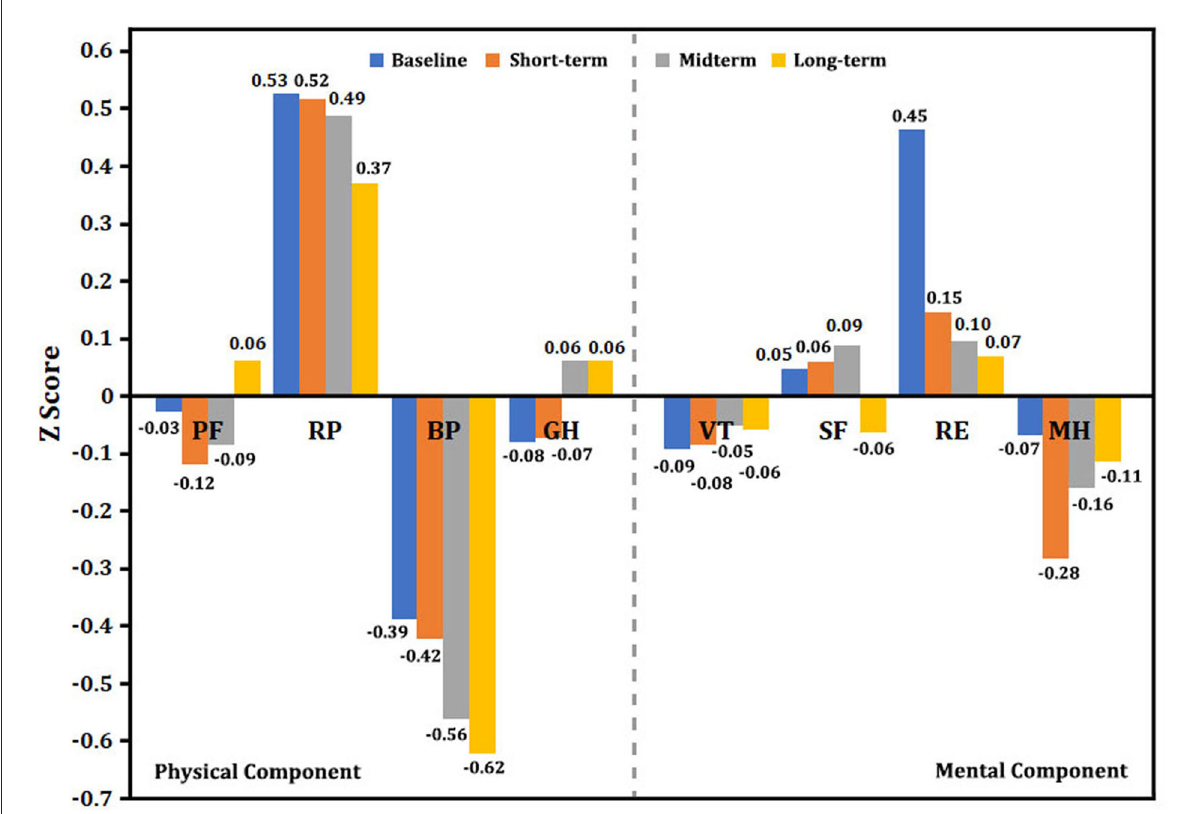
FIGURE5 Single-scale norm-based Z score for the changing trend in SF-36. Normed by the 1998U.S. general population (mean, 0; standard deviation, 1). A Z score < 0 indicates lower health status. The greater the absolute value of a negative number, the worse the health status. A higher positive value represents better health status. BP, body pain; GH, general health; MH, mental health; PF, physical functioning; RE, role emotion; RP, role physical; SF, social functioning; VT,